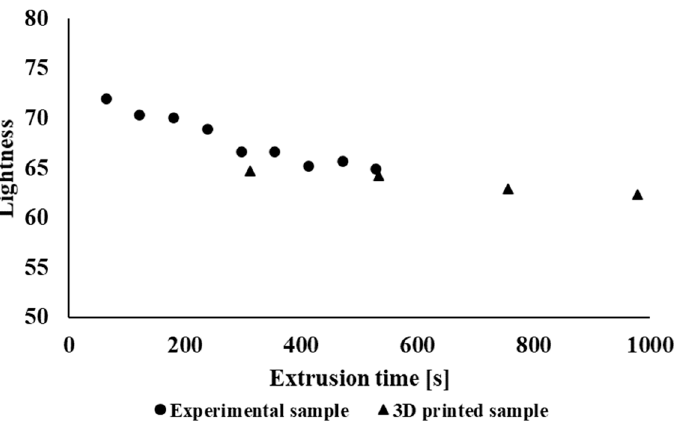
Figure 10. Dependence of material lightness on material retention time in equipment for experimental samples as well as 3D printed objects of industrially processed samples of NONOILEN ® 3D 3056-2.